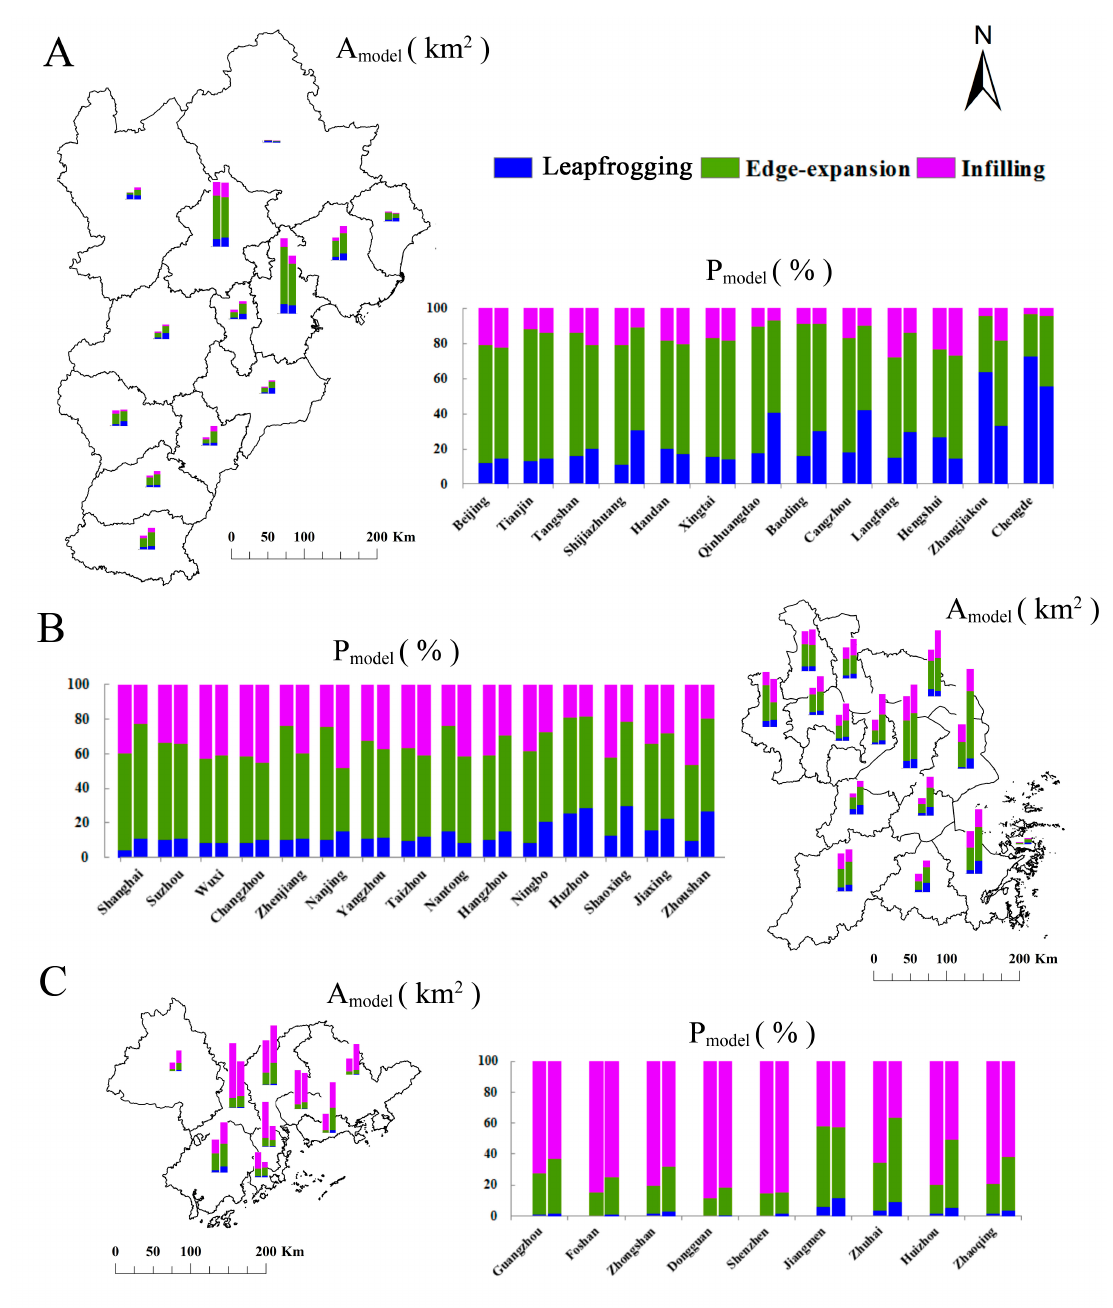
Figure 5. The area and proportion of the three expansion models for the cities located in the BTH ( A ); YRD ( B ) and PRD ( C ) urban